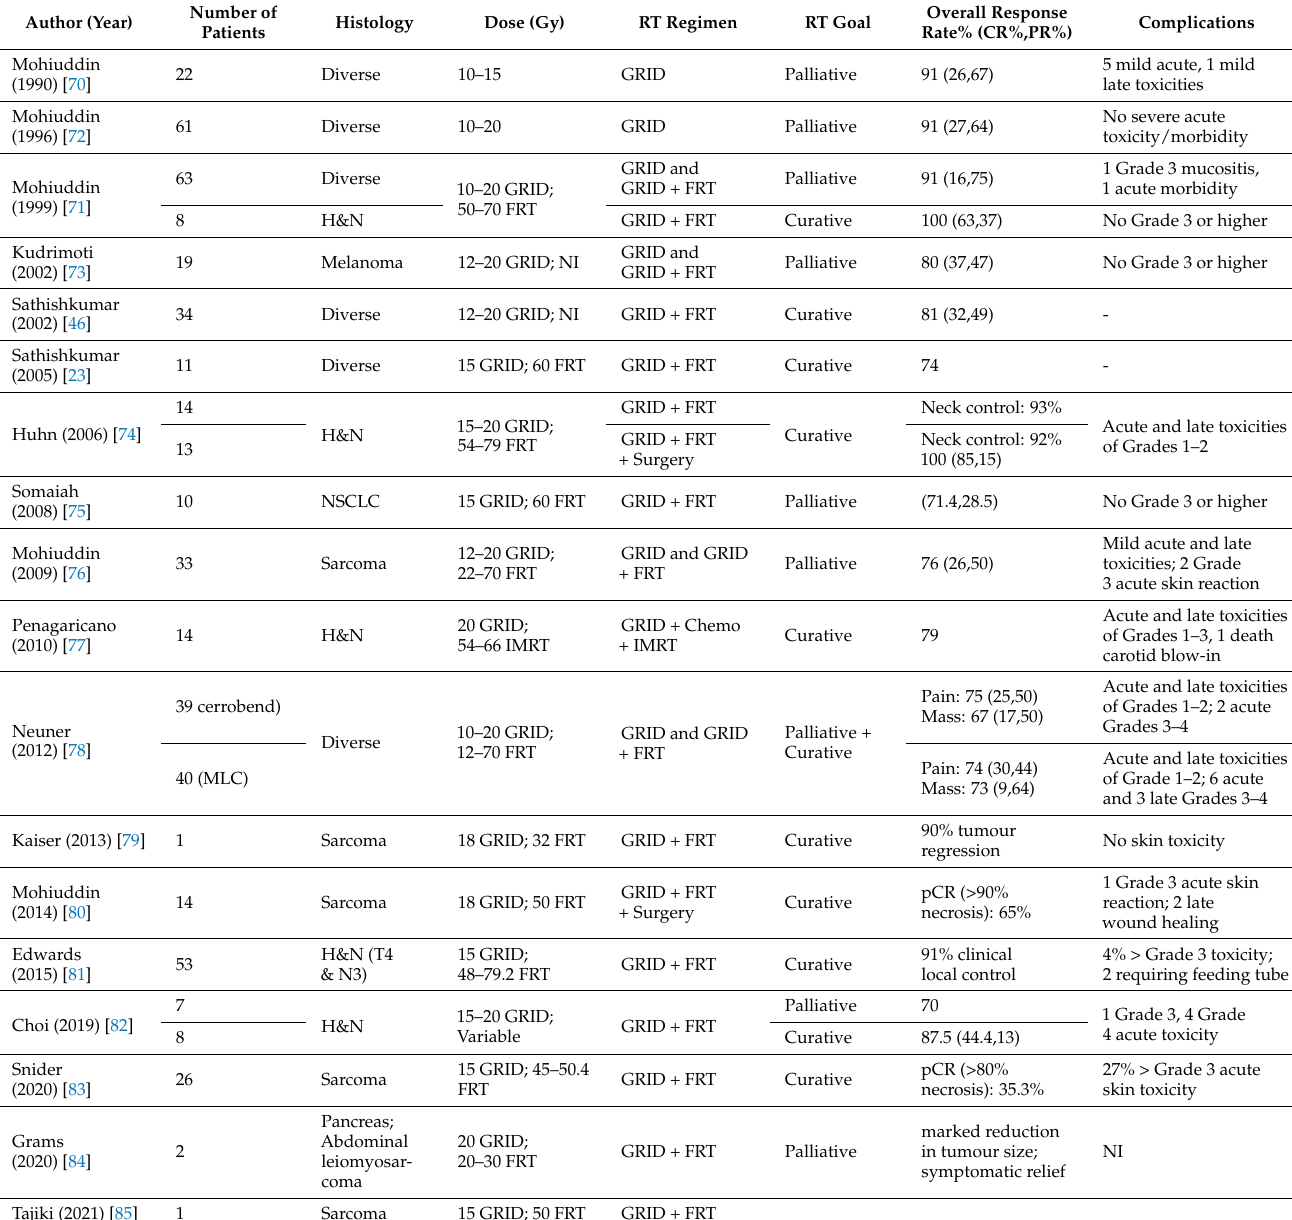
Table 1. Summary of clinical studies reporting on the response rate and normal tissue complications of GRID RT with photons. FRT: fractionated radiotherapy; CR: complete response rate; PR: partial re- sponse rate (50%); NI: not indicated; H&N: head and neck cancer; pCR: pathologic complete